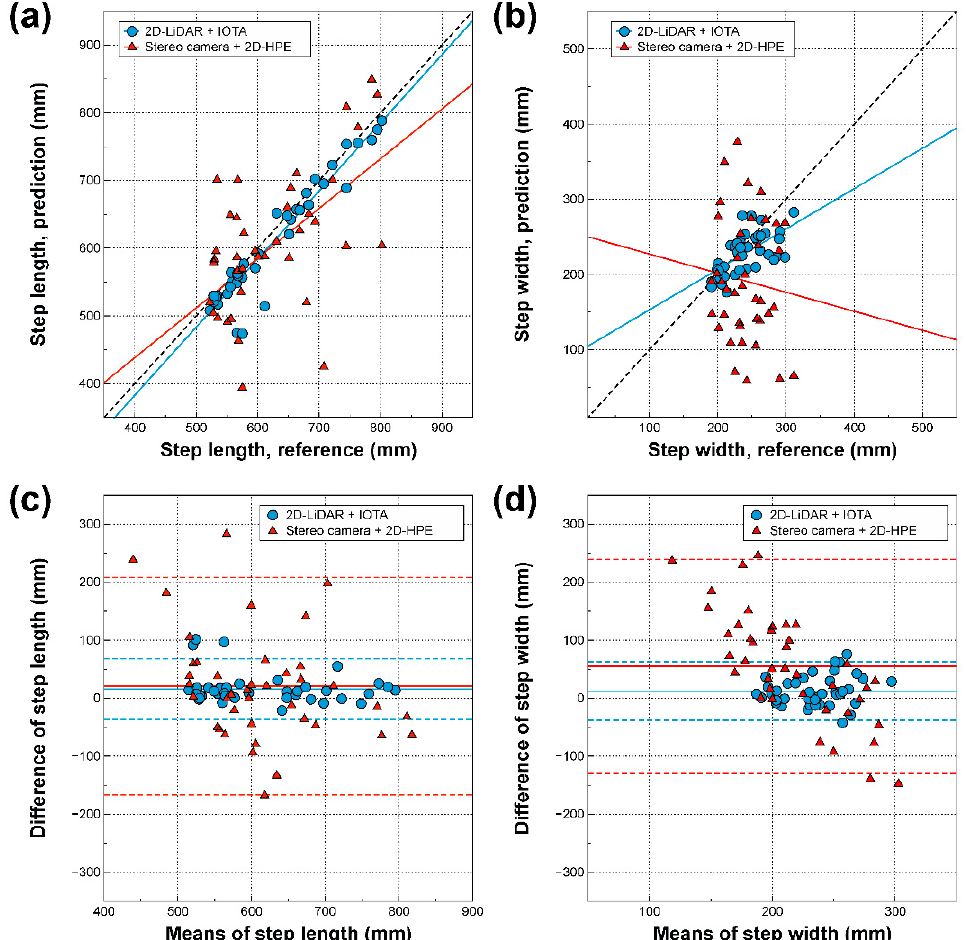
Figure 4. Step length and width derived from spatiotemporal locations of tracked ankles via 2D- LiDAR with IOTA and stereo camera with 2D-HPE. ( a , b ) Regression and ( c , d ) Bland-Altman plots with motion capture system for 2D-LiDAR with IOTA and stereo camera with 2D-HPE for step length ( a , c ) and step width ( b , d ). The black dotted lines in the regression plots are ideal lines for perfect correlations. In the Bland–Altman plots, each solid horizontal line represents the bias of each modality. The upper and lower dashed horizontal lines from each bias represent 95% confidence intervals.